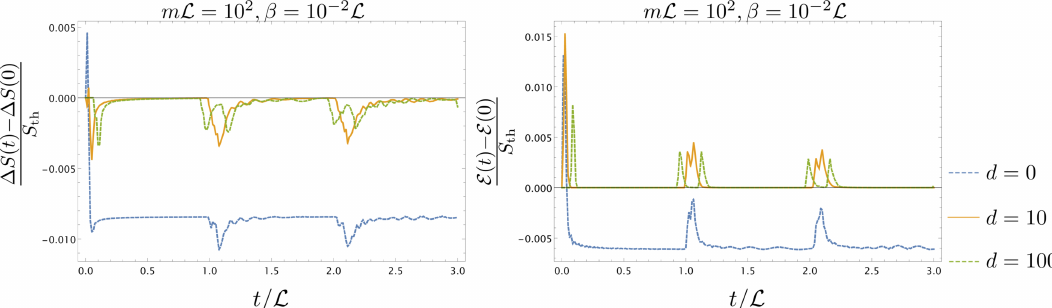
= N + N =20+31 . A L ( R ) A L 1( R 1) A L 2( R 2)